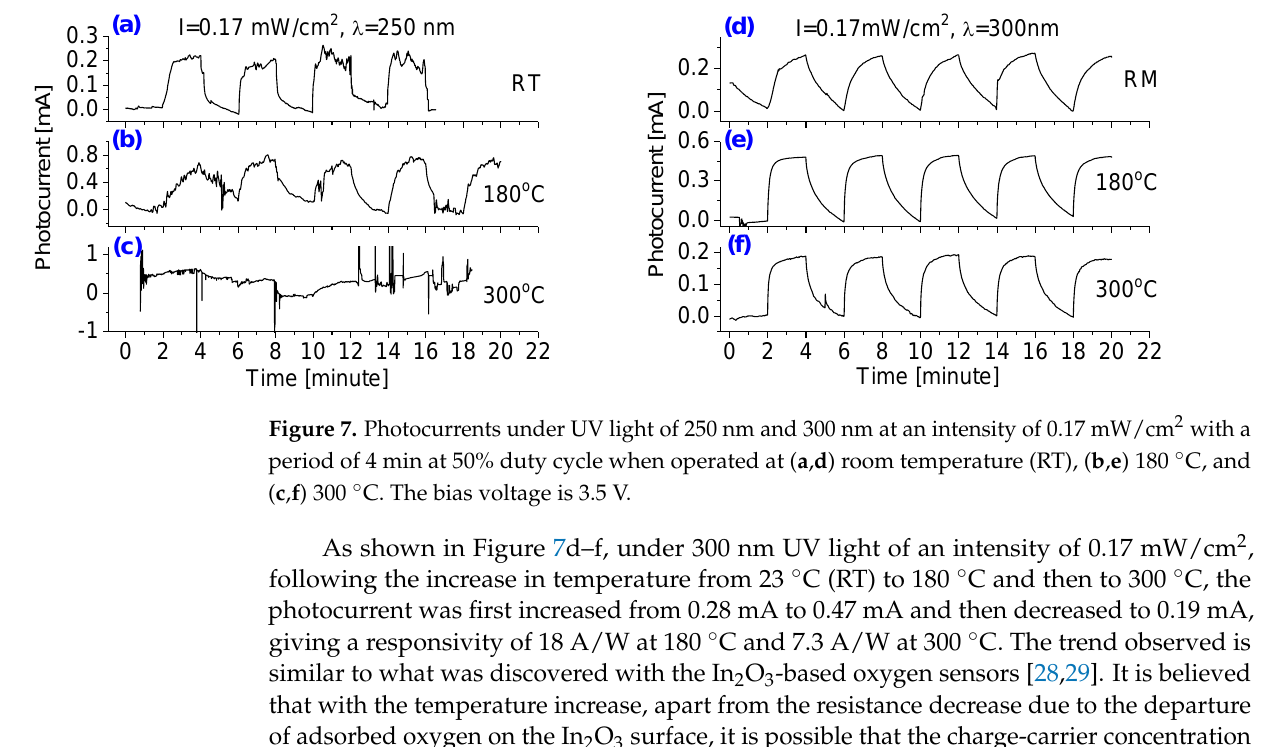
Table 1. Comparison of the key device performance of the reported UV photodetectors. Material